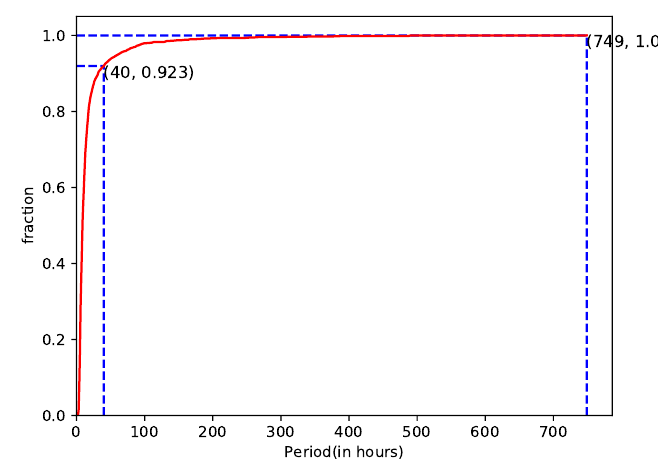
Figure 4. The cumulative reported period distribution of asteroids in our data